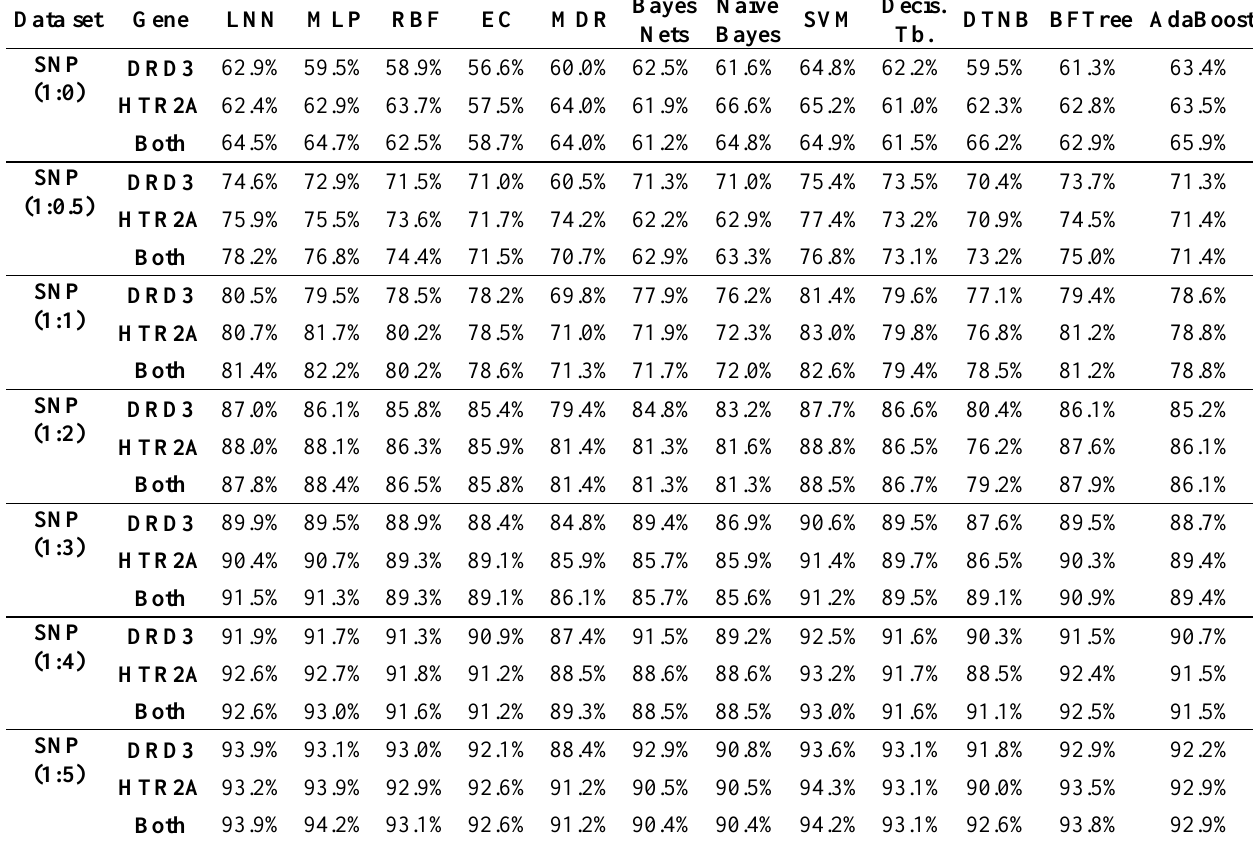
Table 1. The classification models obtained for the evaluated schizophrenia patients using the SNP information at DRD3 and HTR2A.